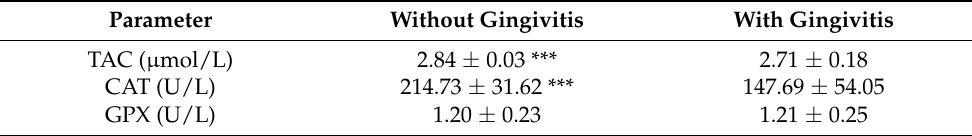
Table 3. Values of total antioxidant capacity of saliva (TAC) and antioxidant enzymes catalase (CAT) and glutathione peroxidase (GPX) in the saliva of subjects with and without gingivitis. Parameter Without Gingivitis With Gingivitis